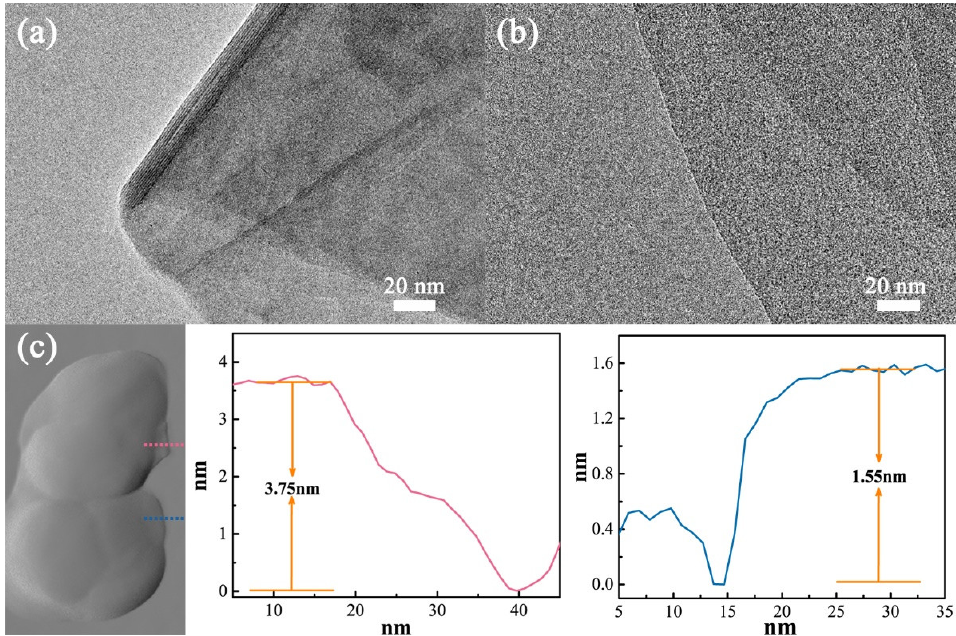
Figure 3. TEM images of the EVMT sheets ( a ) and IEVMT sheets ( b ), and the AFM characterization of IEVMT ( c ).